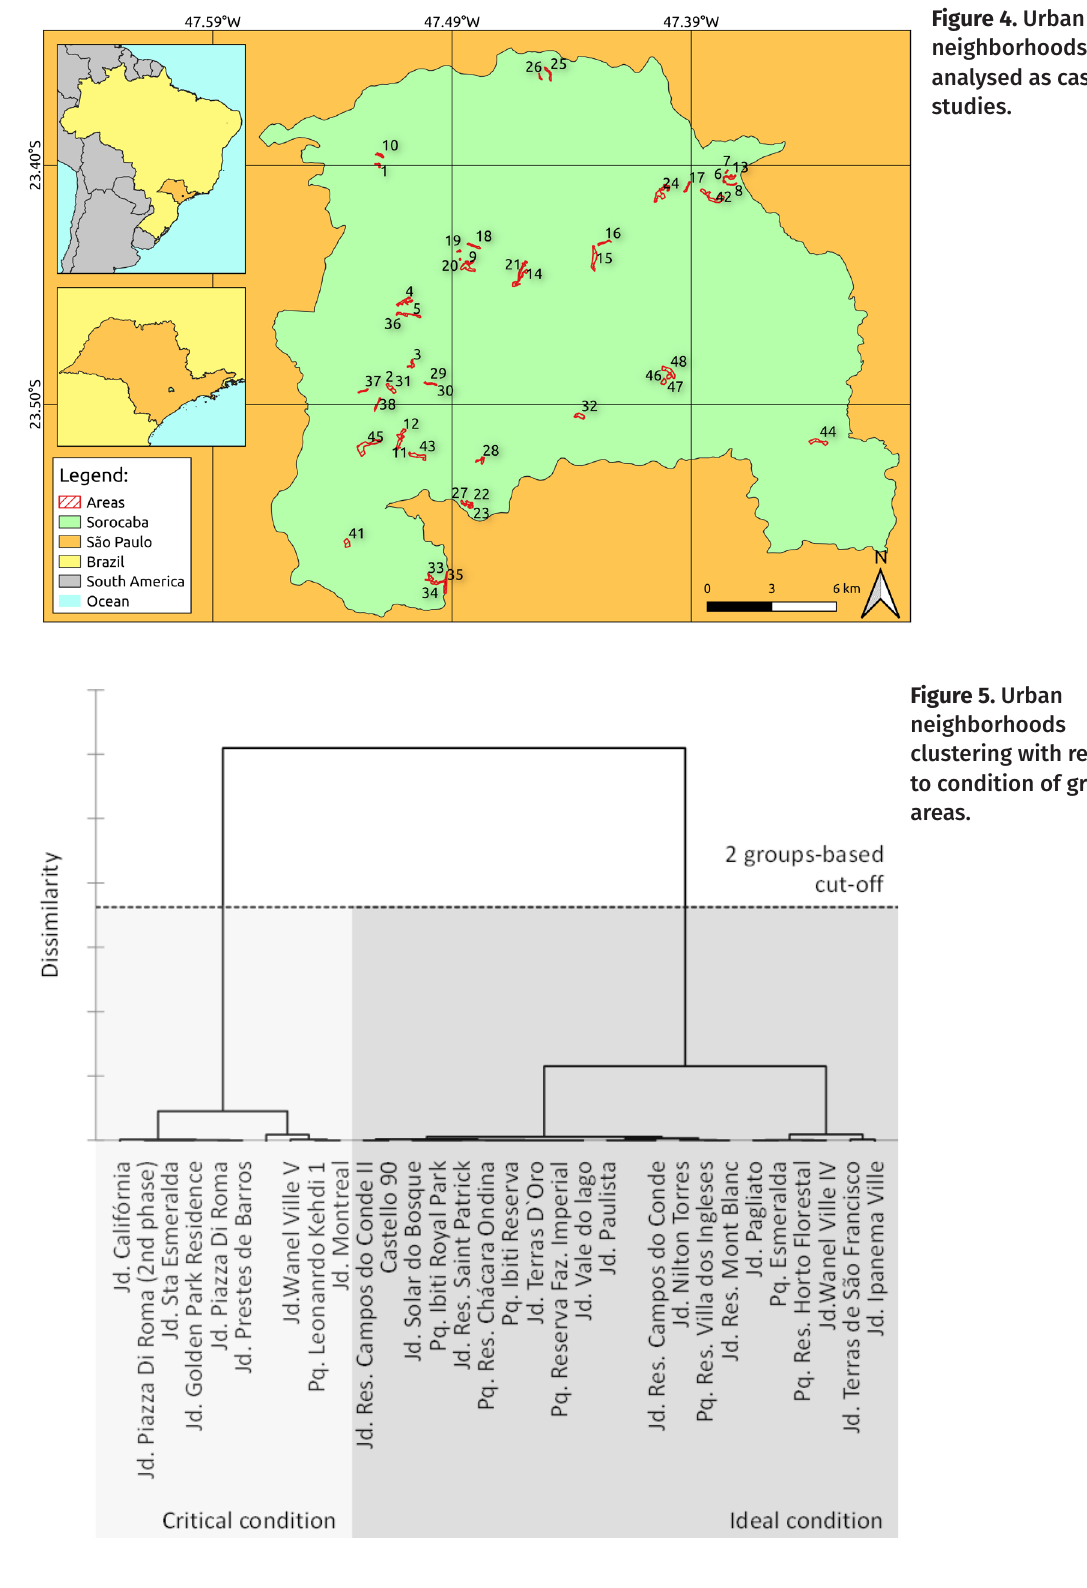
Figure 4. Urban neighborhoods analysed as case studies.